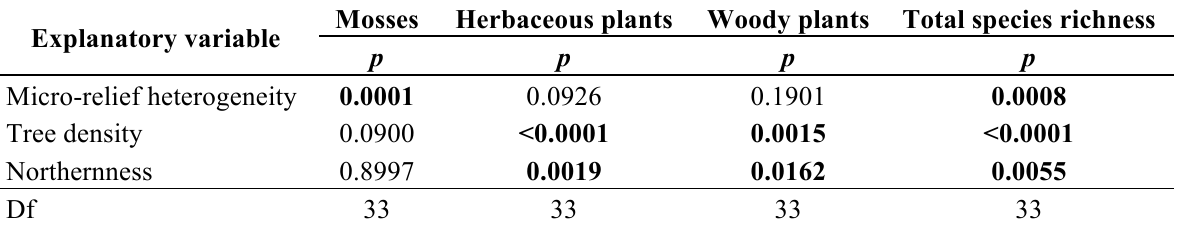
Table 1. Linear mixed-effects models of species richness (subdivided into mosses, herbaceous plants, woody plants and total species richness) and the corresponding environmental and spatial variables (micro-relief heterogeneity, tree density, northernness). The altitude was included as a random effect. Significant results (p < 0.05) are shown in bold. Df denotes the degrees of